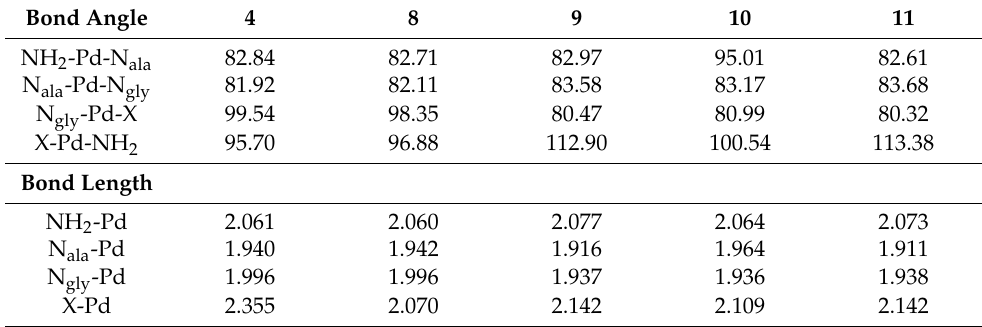
Table 1. Calculated bond angles ( ◦ ) and lengths (Å) for complexes 4 , 8 – 11 . X = Cl ( 4 ), Lu ( 8 ), or -OMe ( 9 , 10 , 11 ).